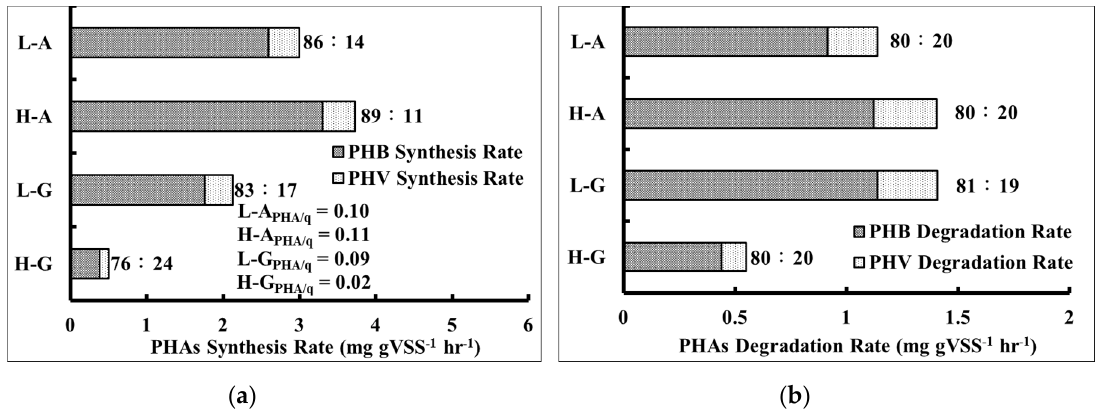
Figure 4. Map of variations in PHA composition. (L-A: low concentration acetic acid, H-A: high concentration acetic acid, L-G: low concentration glucose, H-G: high concentration glucose). ( a ) PHAs Synthesis Rate; ( b ) PHAs Degradation Rate